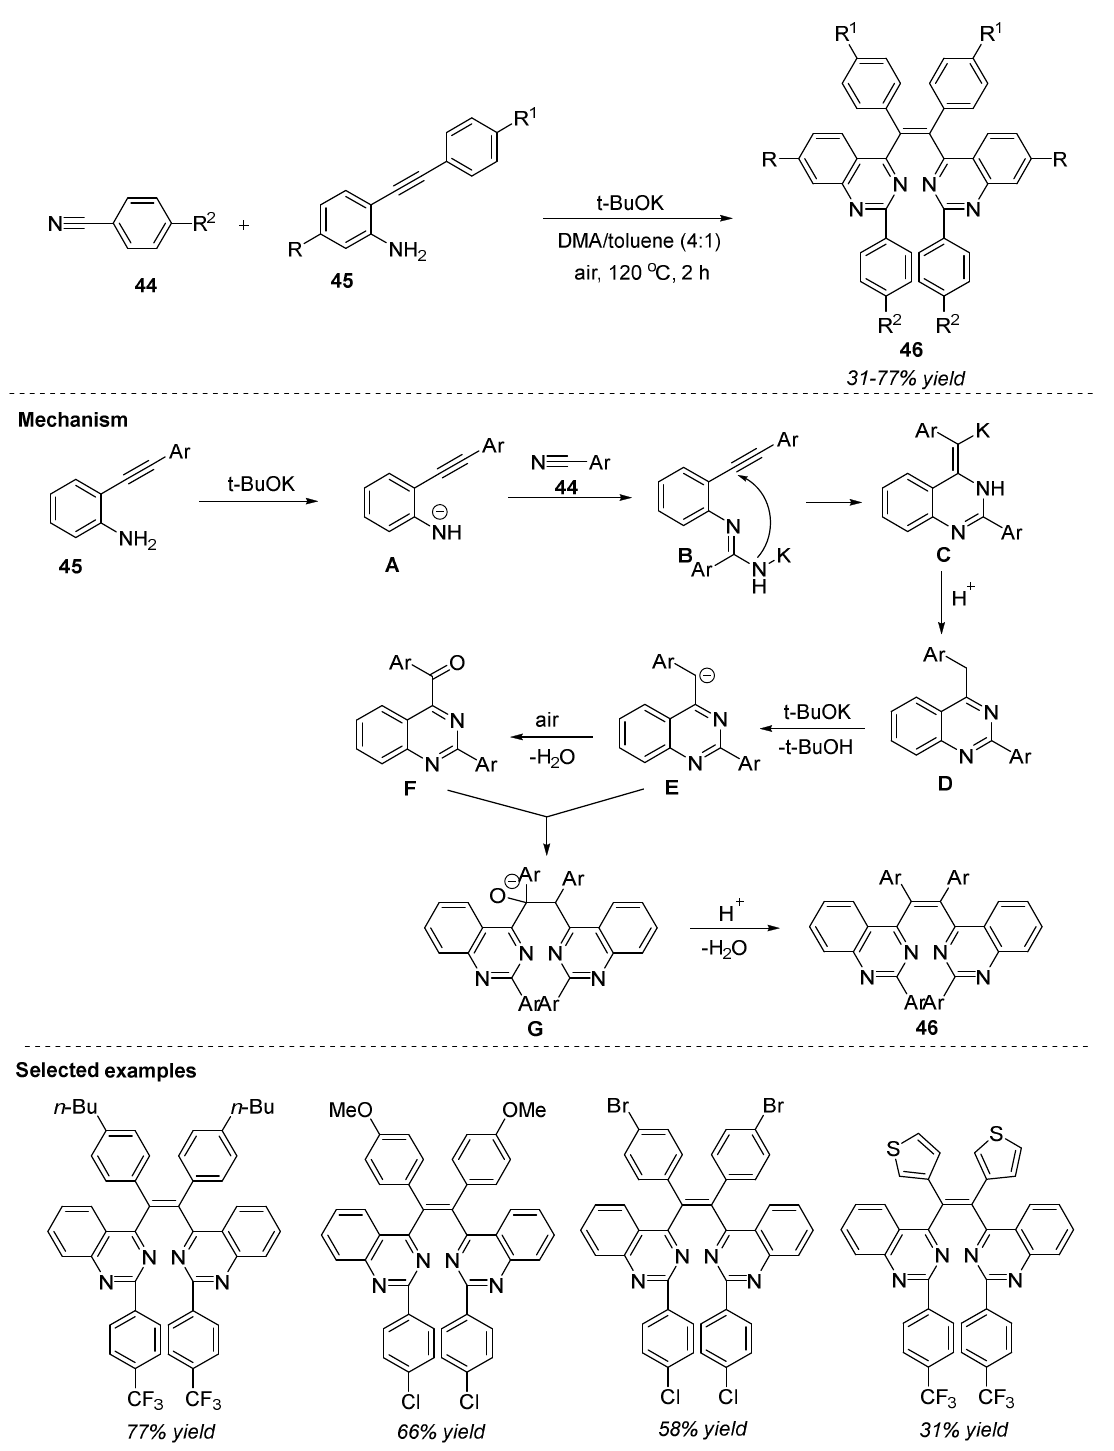
attack of E afforded F . In the last step, the desired product 46 is formed with the elimina- tion of one water molecule from G (Scheme 21). The benzene ring at the 2-position of quinazoline drives the stereoselectivity by forming a stereoregular